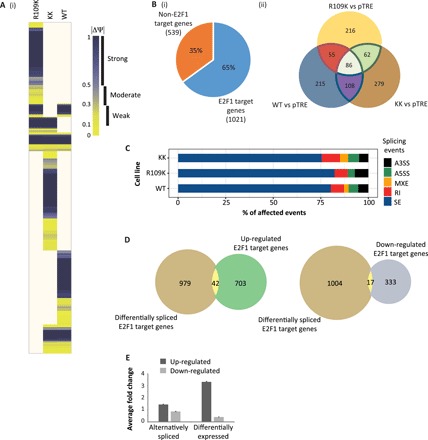
E2F1 affects alternative splicing of E2F target genes.(A) A heatmap displaying absolute values of ΔΨ (percent spliced in) for each cell line, corresponding to statistically significant alternative splicing event changes to E2F1 target genes (as determined by the presence of ChIP-seq peaks in their promoter and gene regions, retrieved from ENCODE data) with respect to the pTRE empty vector cell line, derived by analyzing the RNA-seq data with rMATS algorithm. Yellow color represents the lowest difference, and blue color represents the highest. Ivory blocks correspond to nonsignificant changes in splicing patterns (FDR > 0.01). See also table S2 and fig. S3. (B) Pie chart showing the percentage of genes identified in the rMATS splicing analysis, which are E2F1 target genes (as determined by the presence of ChIP-seq peaks in their promoter and gene regions, retrieved from ENCODE data) (i). The Venn diagram demonstrates the overlap of E2F1 target genes affected by alternative splicing events (FDR < 0.01) in each cell line (ii). These data were generated from three independent biological samples. (C) Bar chart displaying the statistically significant alternative splicing events to E2F target genes for each cell line, as compared to the pTRE vector control. The percentage of these alternative splicing changes corresponding to different types of splicing event is displayed in different colors. SE, skipped/cassette exon; RI, retained intron; MXE, mutually exclusive exons; A5SS, alternative 5′ splice site; A3SS, alternative 3′ splice site. See also fig. S2B. (D) Venn diagrams showing overlap between E2F1 target genes identified in the differential expression analysis as being up- or down-regulated (regulated greater than twofold; Fig. 1B) and those identified as being differentially or alternatively spliced [(A) and table S2]. These data were generated from three independent biological samples. (E) Bar chart representing the average fold change in expression of differentially expressed E2F1 target genes (regulated greater than twofold), compared with the expression of those E2F1 target genes where alternative splicing occurred. Only 389 genes from the alternative splicing analysis met the significance threshold for differential expression (P < 0.01). The remaining 632 spliced genes had expression levels that were not significant from the pTRE empty vector cell line (P > 0.01) and were therefore assigned an arbitrary value of 1 for this analysis.